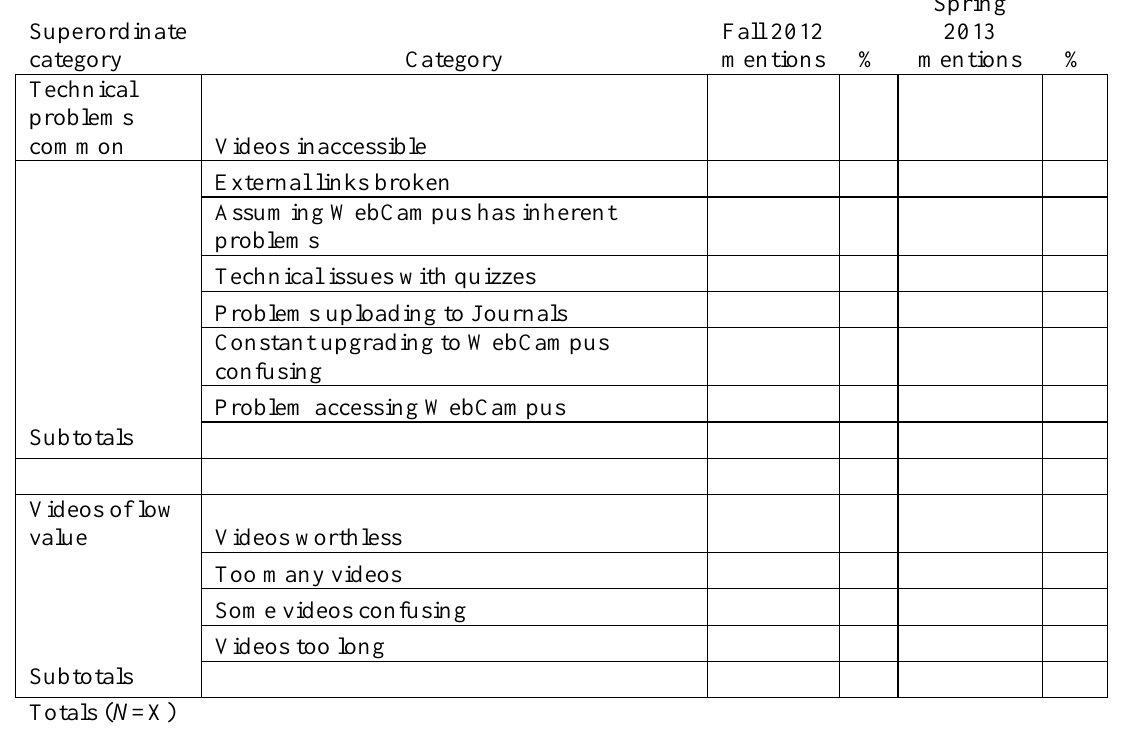
Figure 4. Recording and organizing categories into a